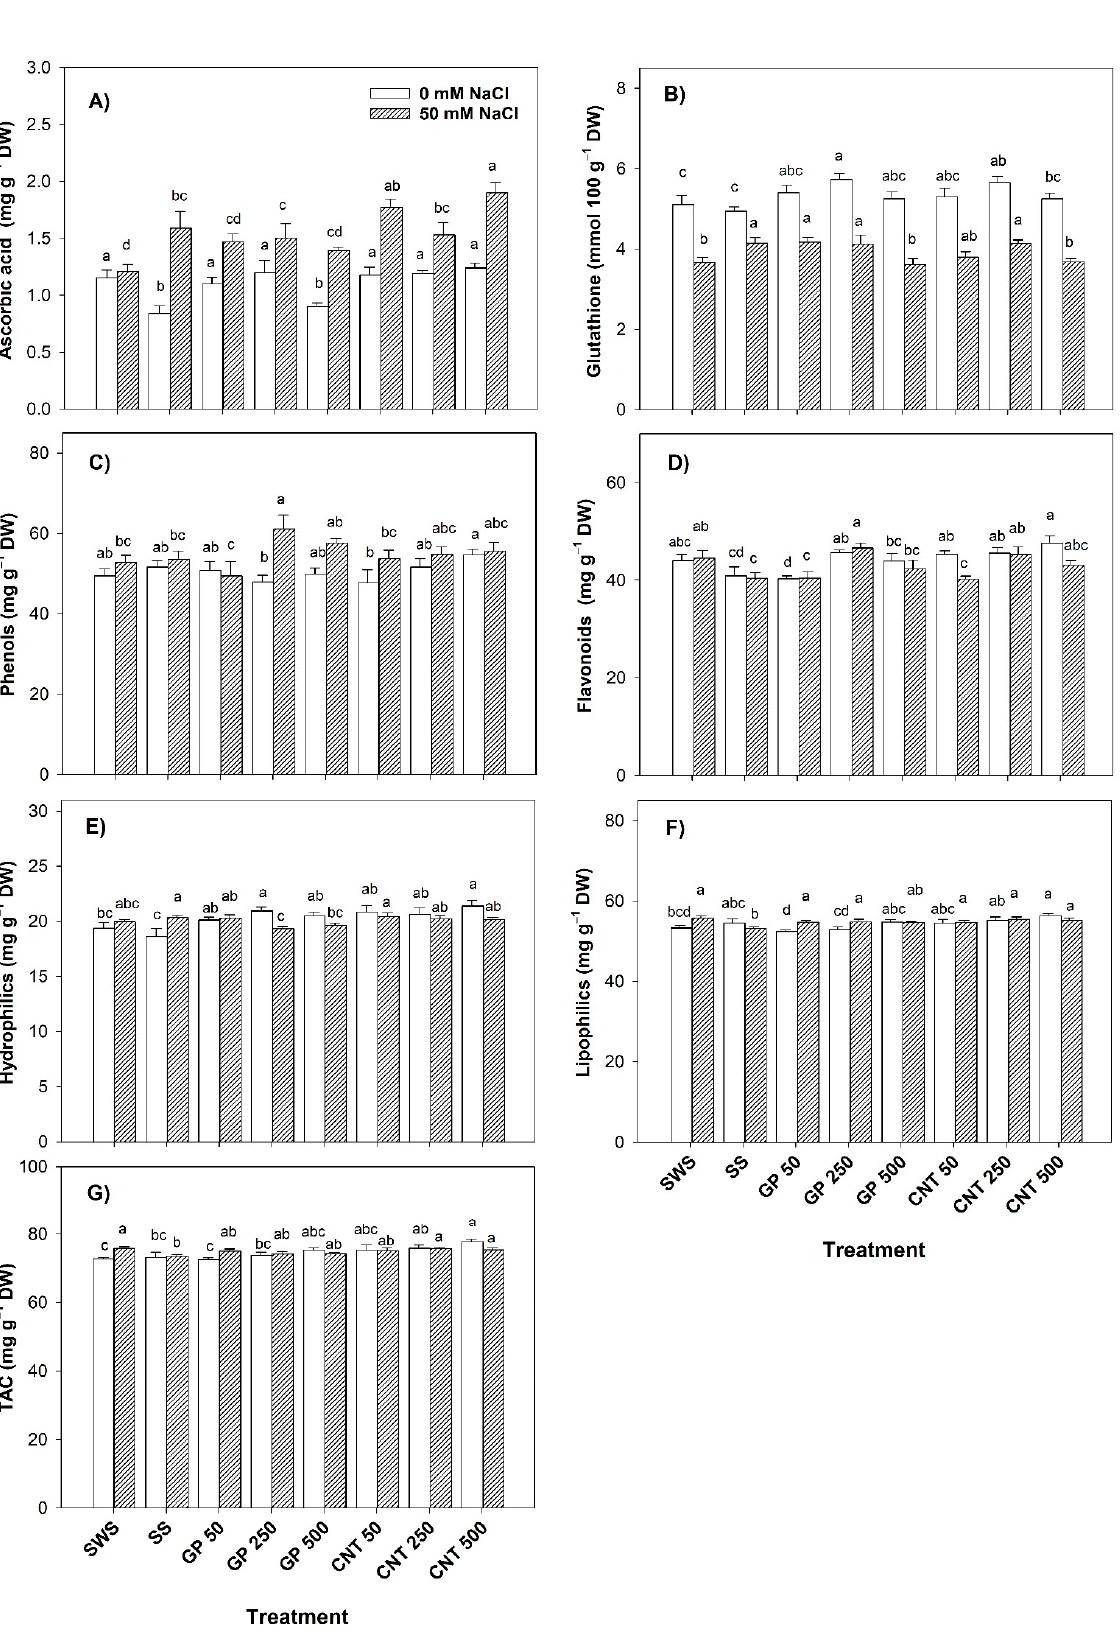
Figure 4. Non-enzymatic antioxidant compounds in tomato plant leaves treated with carbon